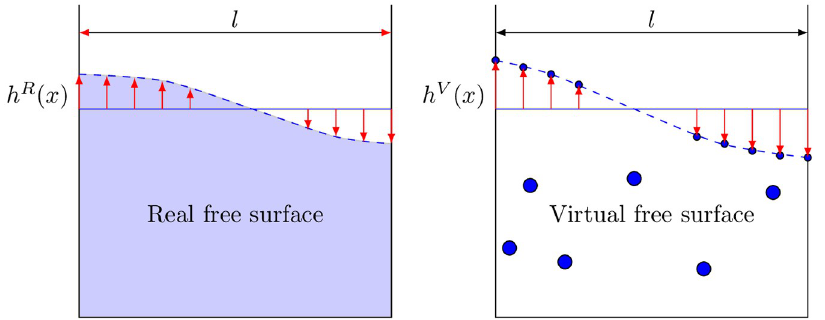
Fig 7. Representation of the quantifiable comparison of the real liquid and the replica. Free surface is defined as a function of its height at different points. These heights are compared in a same snapshot to evaluate the reconstruction error.